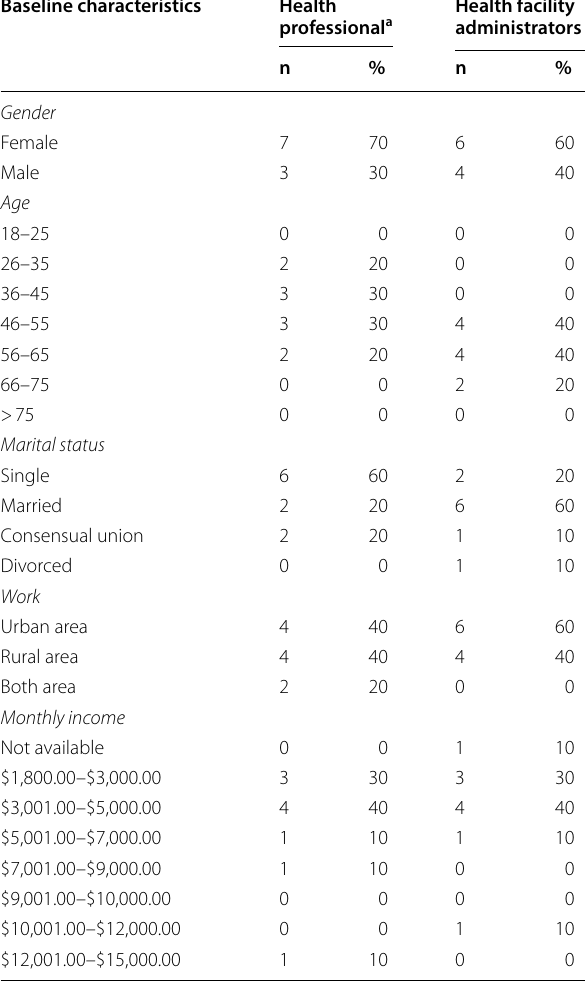
Table 1 Sociodemographic characteristics of health care system professionals Baseline